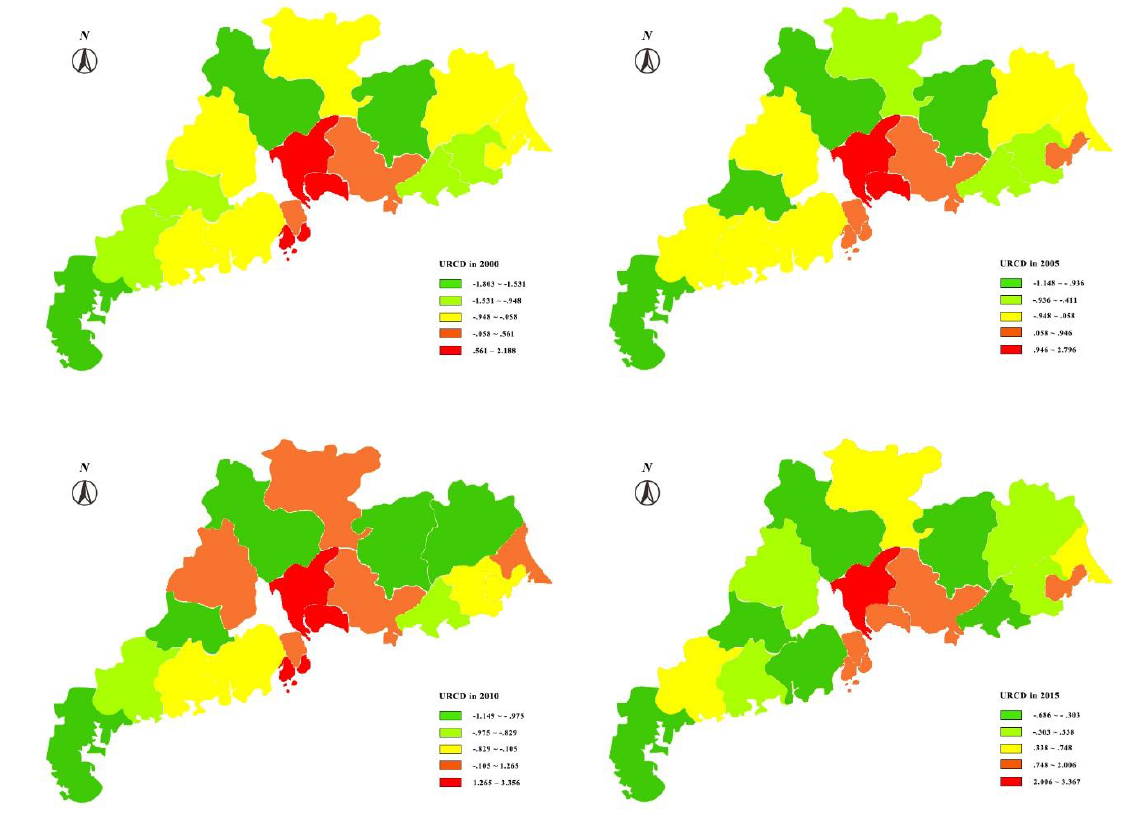
Figure 3. Spatial distribution of URCD (2000–2015).